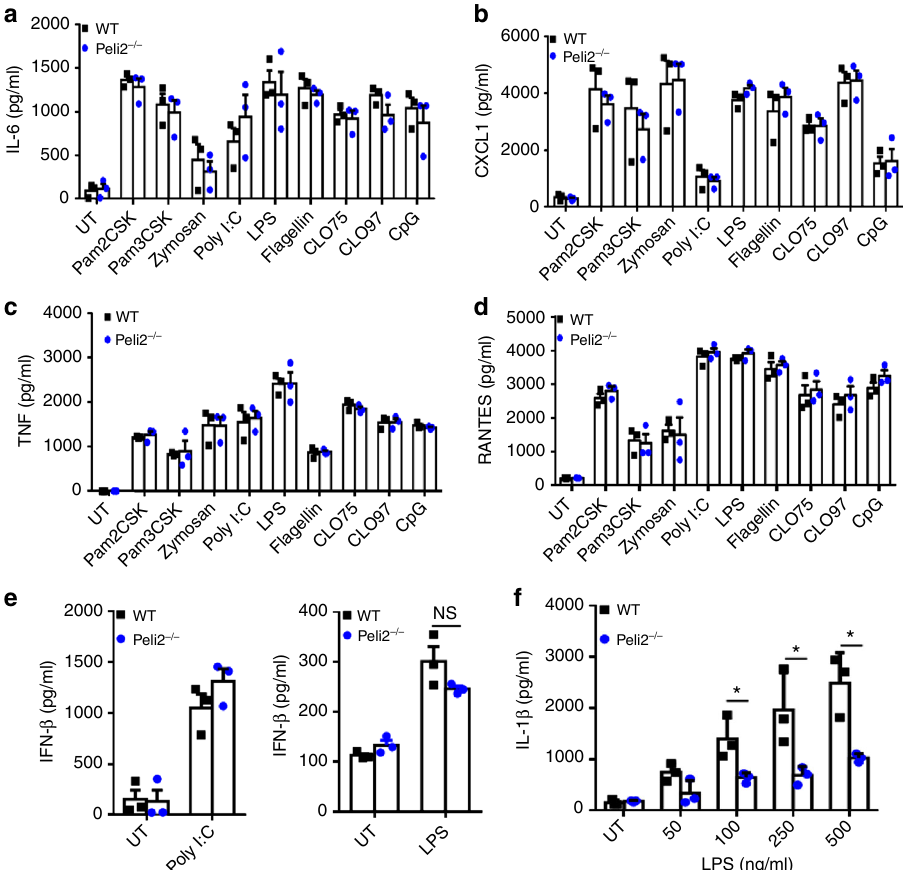
Fig. 1 Pellino2 is required for production of IL-1 β in response to LPS. a-e Enzyme-linked immunosorbent assay (ELISA) of a IL-6, b CXCL1, c TNF, d RANTES, and e IFN- β expression in medium from BMDMs isolated from wild-type (WT) and Pellino2-de fi cient ( Peli2 − / − ) mice and treated with 10 ng/ml Pam2CSK, 10 ng/ml Pam3CSK, 1 μ g/ml Zymosan, 25 μ g/ml poly(I:C), 100 ng/ml lipopolysaccharide (LPS), 1 μ g/ml fl agellin, 1 μ g/ml Clo75, 1 μ g/ml Clo97, and 2 μ g/ ml CpG for 24 h. UT, untreated. f ELISA of IL-1 β in medium from WT and Peli2 − / − BMDMs stimulated with the indicated concentrations of LPS for 24 h. * p < 0.05 (paired, two-tailed Student ’ s t -test). Data are presented as the mean of three independent experiments ( a-f ). Error bars, (Fig. 1a), CXCL1 (Fig. 1b), TNF (Fig. 1c), RANTES (Fig.1d), and